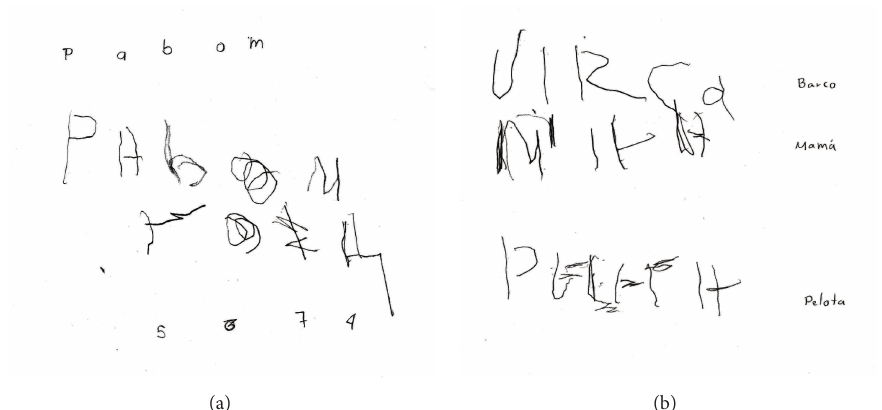
Figure 4: Writing by dictation: barco (boat), Mama (Mom), and pelota (ball) on the right; p, a, b, o, m, 5, 6, 7, 4 on the